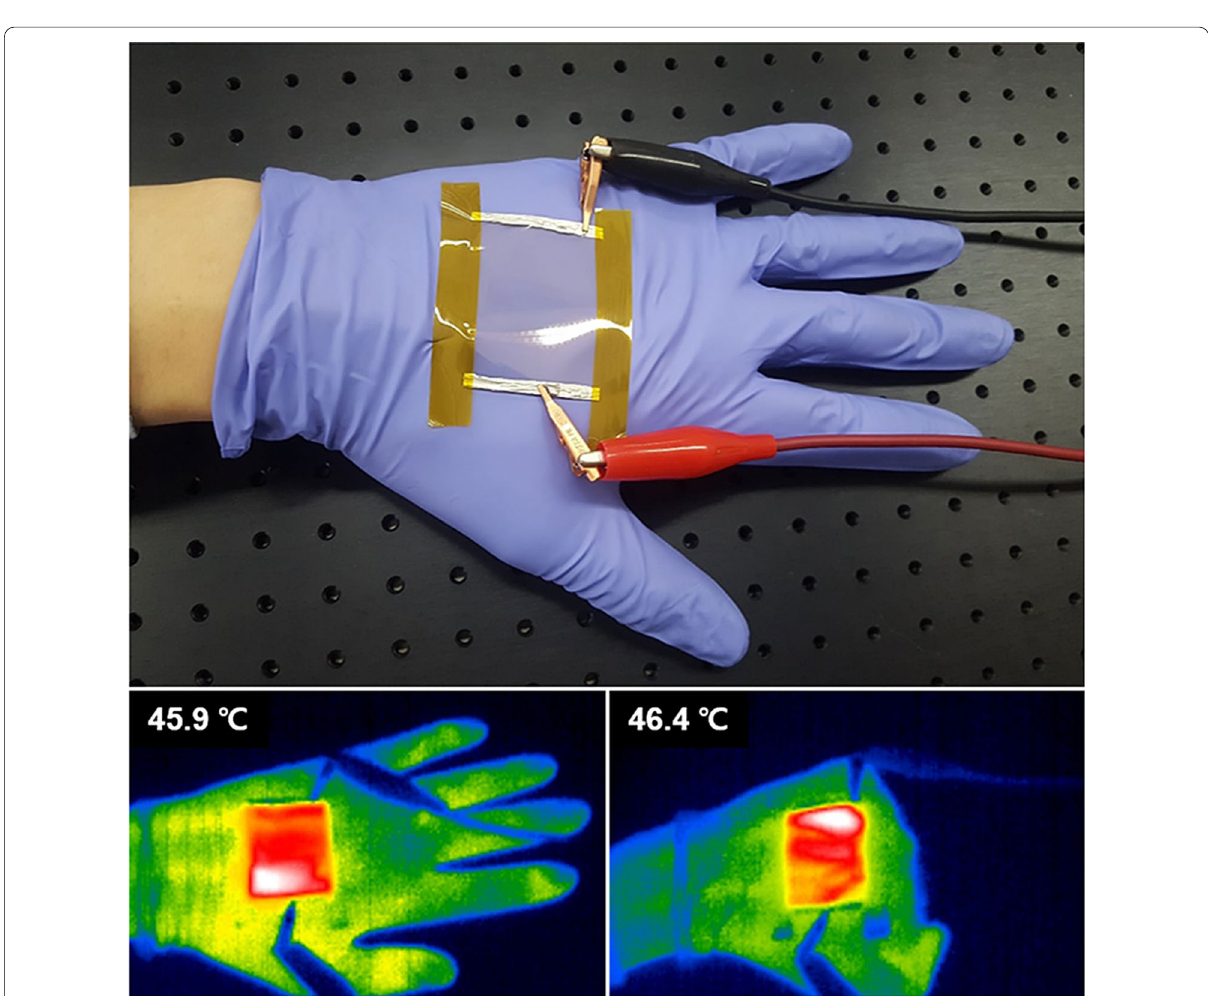
Fig. 7 Photograph and IR thermal images of the operation of the Cu mesh/PVA film‑based TH (45 mm